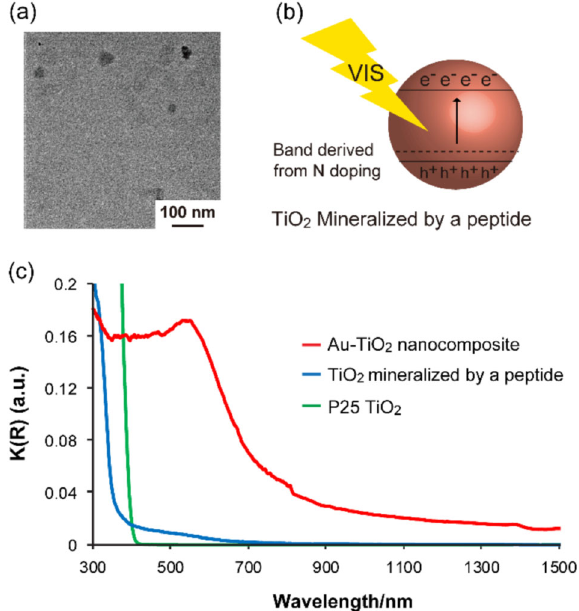
Fig. 5 Detailed analysis of the photocatalytic activity of gold-titania nanocomposites. a TEM image of the sample calcined at 700°C after titania and gold precipitation using TiPP-PNA and AuPP-acidine without TempDNA. b Schematic illustration of an energy diagram of titania mineralized by a peptide. c UV – VIS – IR DRS absorption spectra of various titania